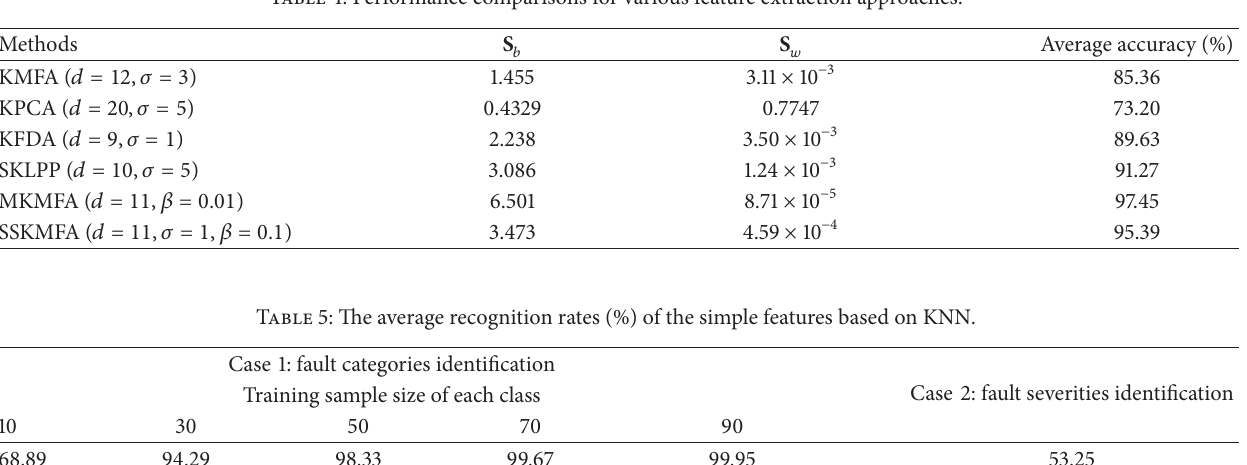
Table 4: Performance comparisons for various feature extraction approaches.